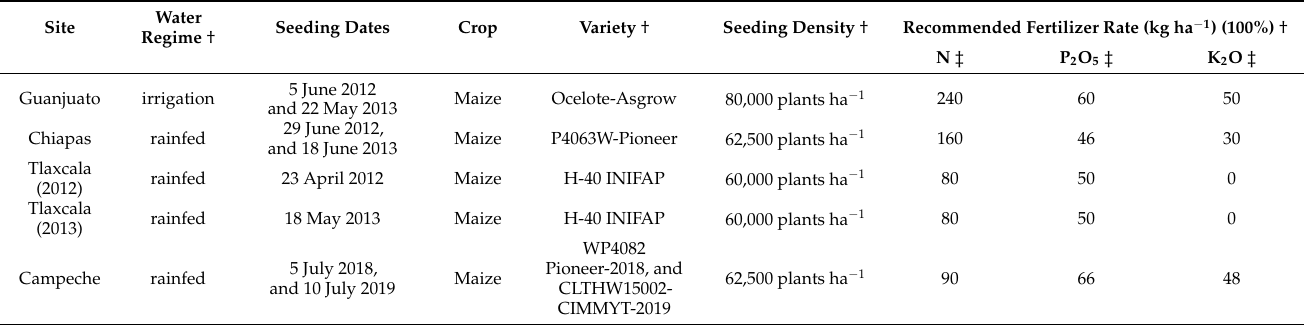
Table 4. Summary of management practices in experimental sites in Mexico, from 2012–2013, and from